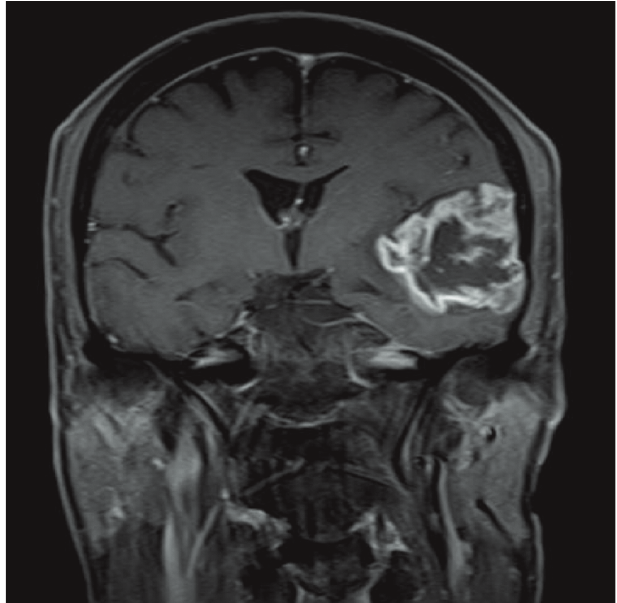
Fig. 3a. T1 coronal post-contrast view shows a large, centrally necrotic, peripherally enhancing